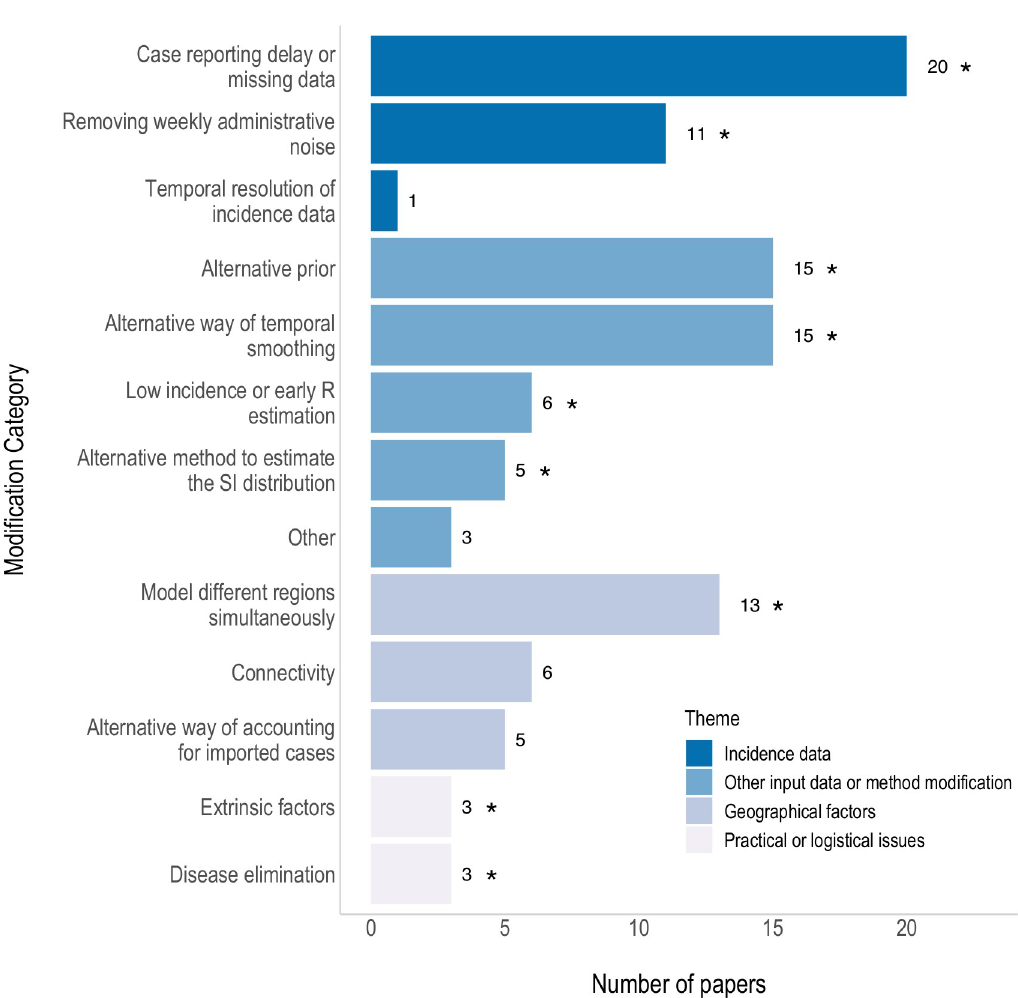
Fig 3. Summary of the modifications made to the EpiEstim method in 54 papers. Papers which made multiple modifications are counted more than once. Asterisks are present next to the modification category if an R package or opensource tool has been identified that addresses an issue within that category. See text for a description of all modifications and Table 2 for a summary of the R packages